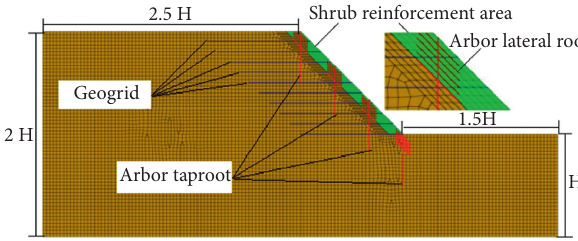
Figure 4: Slope model. Table 1: Mechanical parameters of the materials.